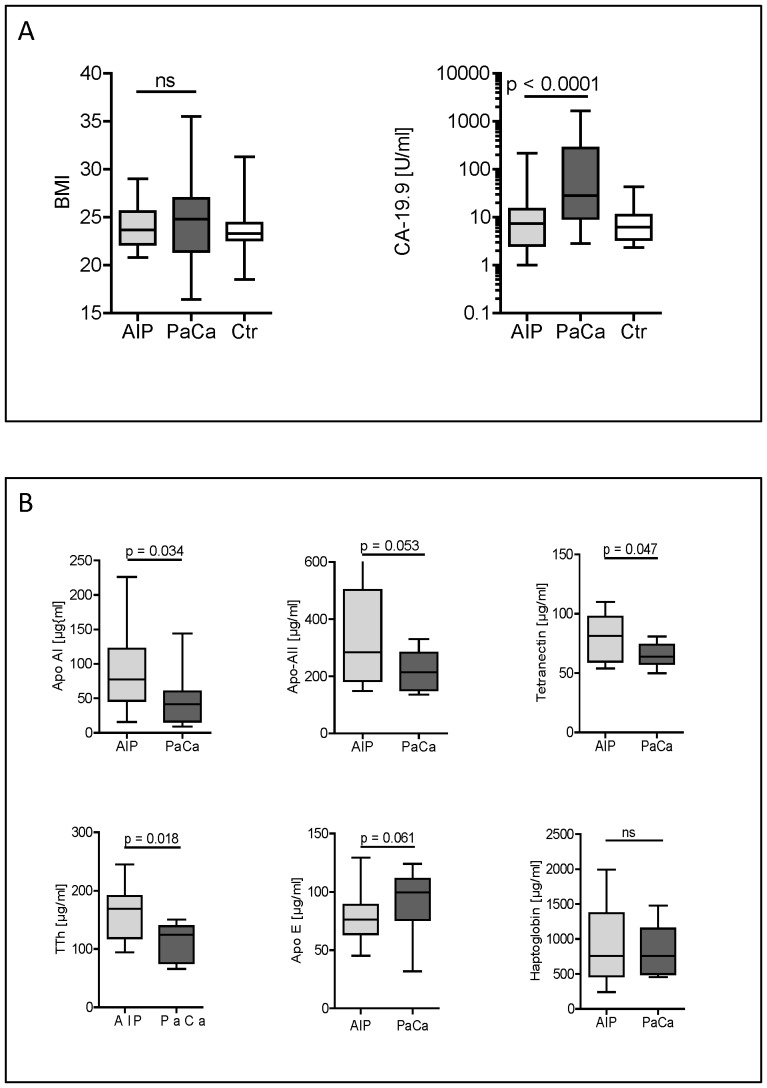
Box plot chart of BMI and of serum analysis.
A: Body mass index and CA 19-9 levels in the AIP-, PaCa- and control-group used in the ELISA-based validations. The BMI and the CA 19-9 values of three groups AIP, PaCa, and Control are presented as box-and-whisker plots. Comparisons between the three groups were performed by using the Kruskal-Wallis test as overall test followed by the Mann-Whitney u test for pairwise comparisons. B: Reevaluation of the ELISAs for the six markers applying a CA 19-9 cut-off of <37 U/ml. With respect to the 6 protein markers the subgroups of AIP and PaCa defined by a CA 19-9 value <37 U/ml were compared with the one-sided Mann-Whitney u test. Significance was accepted by the 95% level. Box plots with max, Q3, median, Q1 and min.